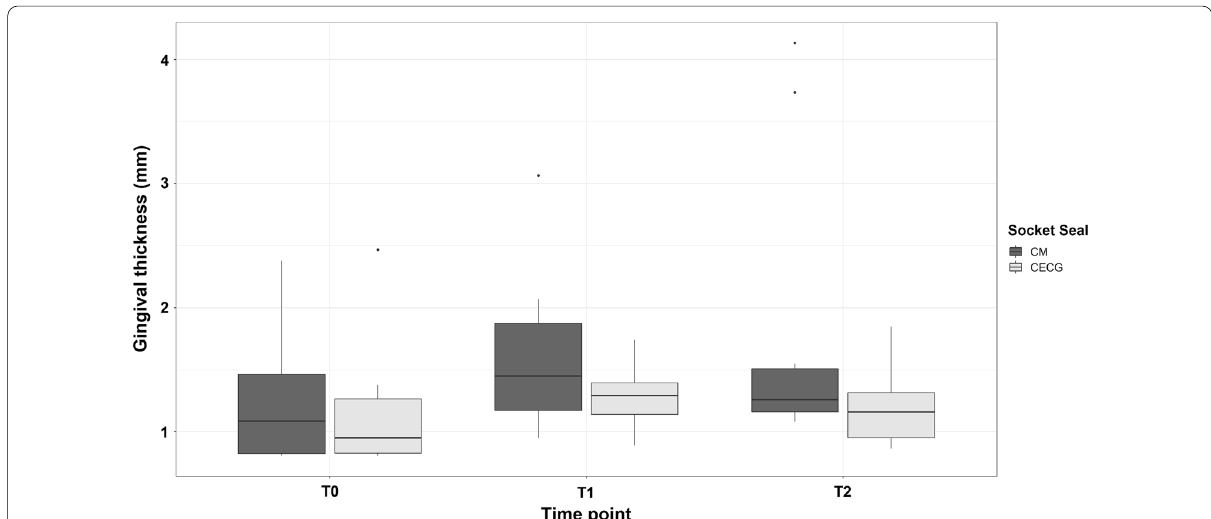
Fig. 3 Comparison of both groups on the basis of the measured gingival thickness at the time points T0 (prior to tooth removal), T1 (prior to implant placement) and T2 (prior to second stage